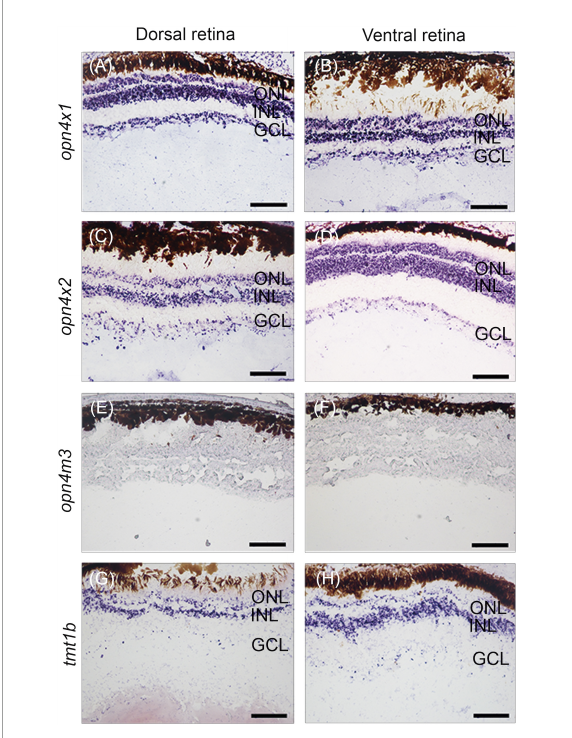
FIGURE2 Non-visual opsin gene expression in the larval retina of Anableps anableps . In situ hybridizations for o pn4 × 1 (A,B) , opn4 × 2 (C,D) , opn4m3 (E,F) , and tmt1b (G, H) were performed in eyes of larvae collected before birth. Sections of the dorsal retina are on the left, and ventral retina to the right. ONL, outer nuclear layer; INL, inner nuclear layer; GCL, ganglion cell layer. Scale bars: 0.05